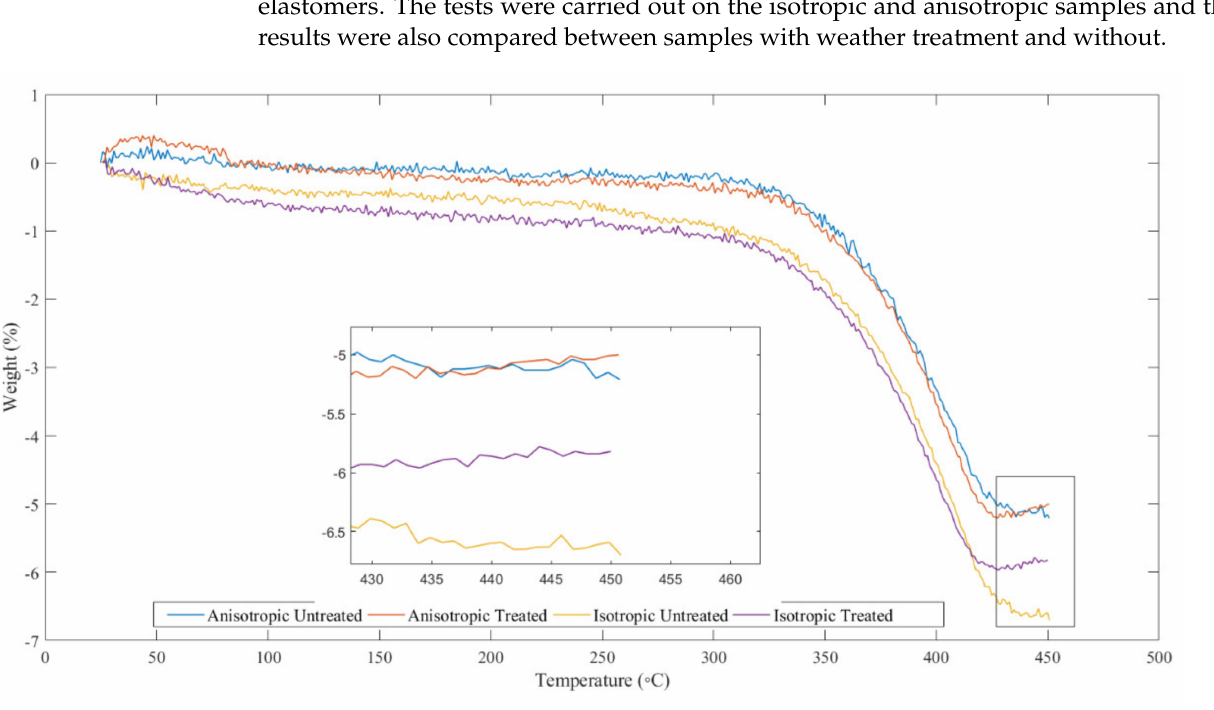
Figure 8. Thermogravimetric curves of MRE